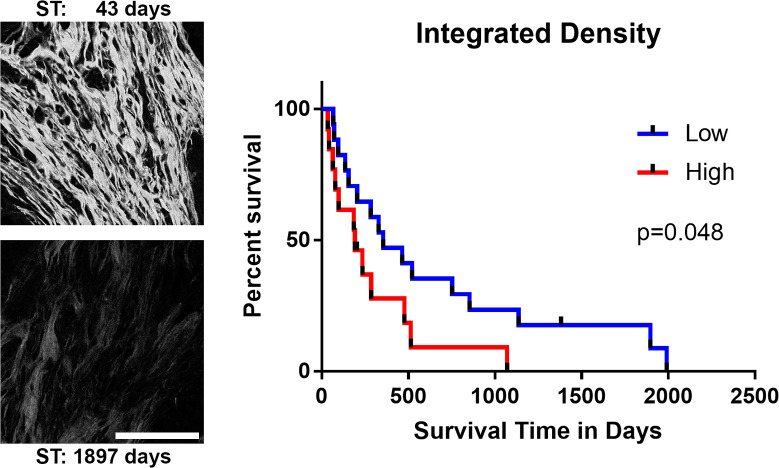
Fibrillar collagen density in feline mammary tumors.Representative images of SHG signal (white) in a tumor from a cat with short survival time (top) and a cat with a long survival time (bottom) following mammary tumor excision. Kaplan-Meier survival curve for 30 cats with collagen integrated density higher or lower than the mean integrated density value. Univariate cox regression was used to evaluate whether the collagen density significantly impacted survival (p = 0.048, hazard ratio 2.125, 95%CI 1.007–4.483). All images in figure are at the same scale. Scale bar: 100μm.